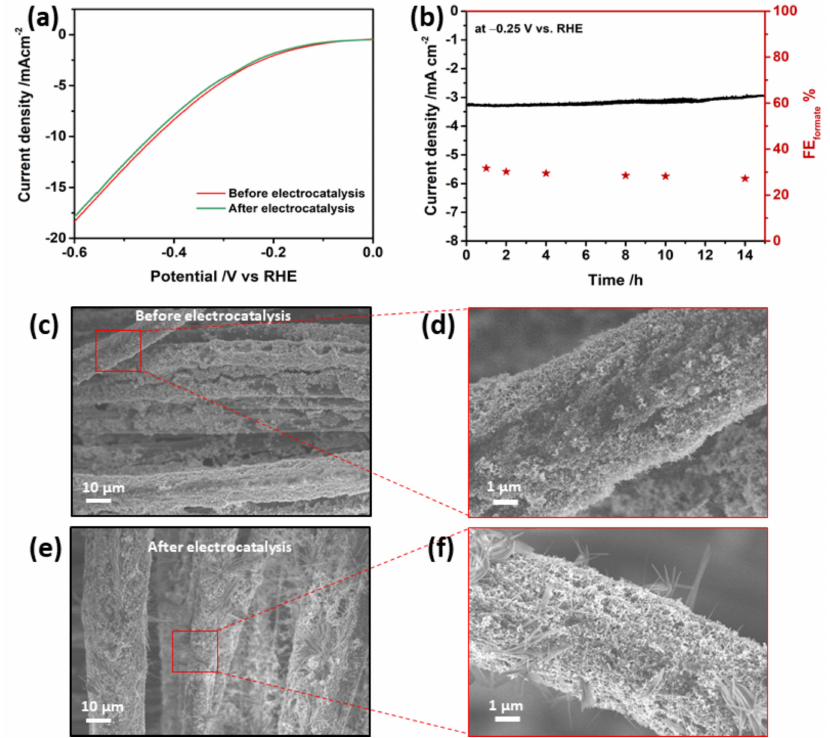
Figure 4. ( a ) LSV curves of Cu-THQ-EFG before and after electrocatalysis; ( b ) the long-term sta- bility test of Cu-THQ-EFG at − 0.25 V vs. RHE for 15 h; ( c , d ) SEM images of Cu-THQ-EFG before electrocatalysis; ( e , f ) SEM images of Cu-THQ-EFG after electrocatalysis.